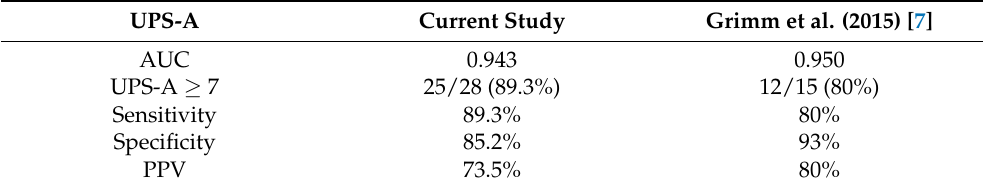
Table 4. Performance of UPS-A in differentiating CIDP from other neuropathies and